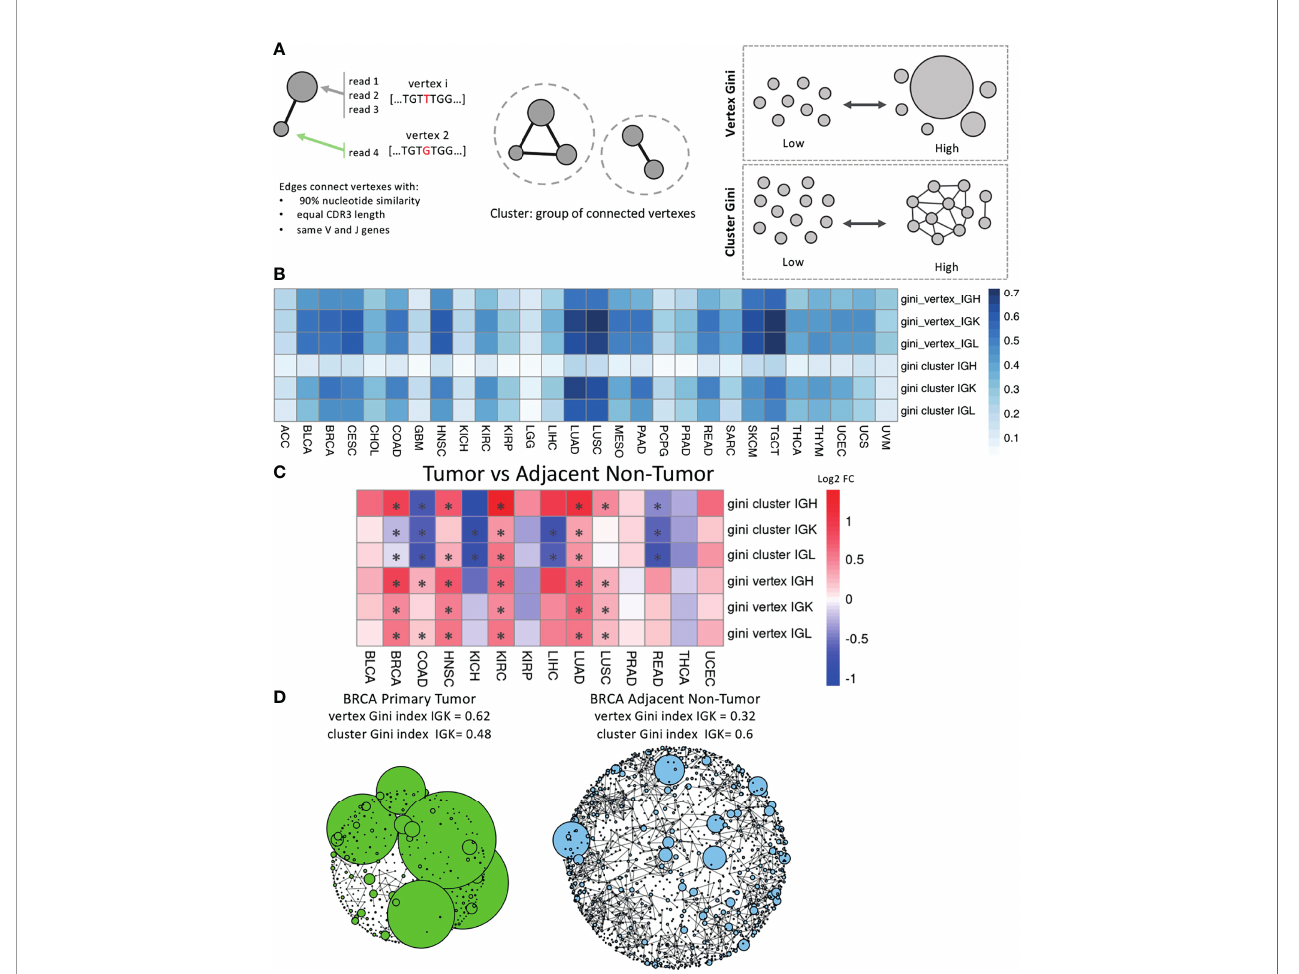
FIGURE 3 | Network analysis across tumor types and between tumor and adjacent non-tumor samples. (A) Schematic describing how the networks were generated for each sample. The vertex Gini index and the cluster Gini index were used to quantify clonal expansion and clonal diversi fi cation. (B) A heatmap showing the mean vertex Gini index and cluster Gini index across tumor types in each chain. (C) A heatmap showing the log2 fold ratio between the mean vertex/cluster Gini index in tumor samples and the mean vertex/cluster Gini index in the adjacent non-tumor samples. Red indicates a higher mean value in tumors and blue indicates a higher mean value in adjacent non-tumor samples. Signi fi cance was computing using the Wilcoxon rank-sum test and the asterisks indicate an FDR < 0.05. (D) Network plots for a BRCA primary tumor sample on the left and a BRCA adjacent non-tumor sample on the right. Vertexes depict unique BCR sequences and sizes indicate the number of reads. Edges are drawn between vertexes that have the same V and J genes, the same CDR3 length, and at least 90% sequence